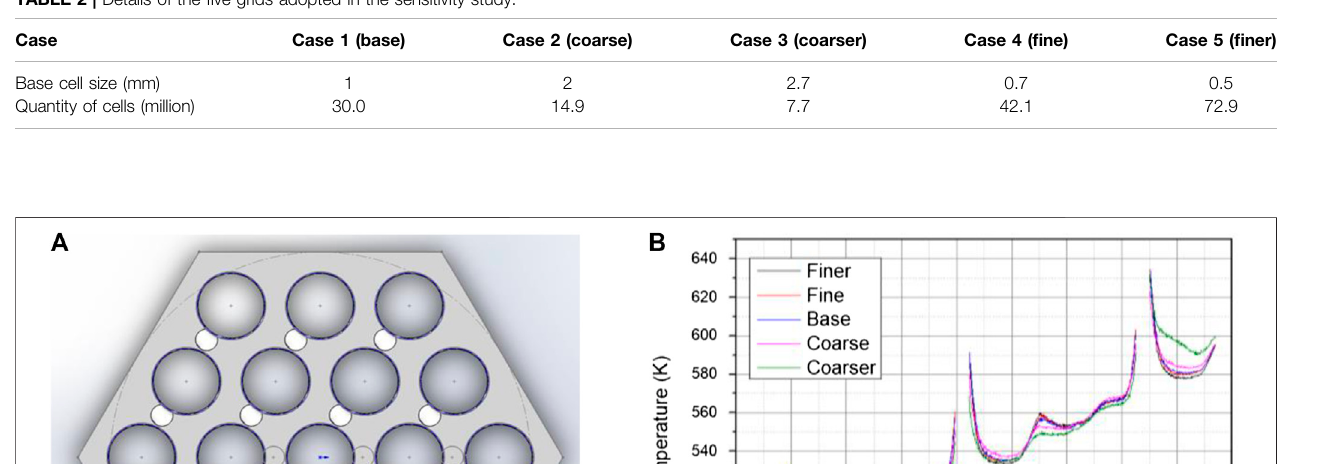
TABLE 2 | Details of the fi ve grids adopted in the sensitivity study.